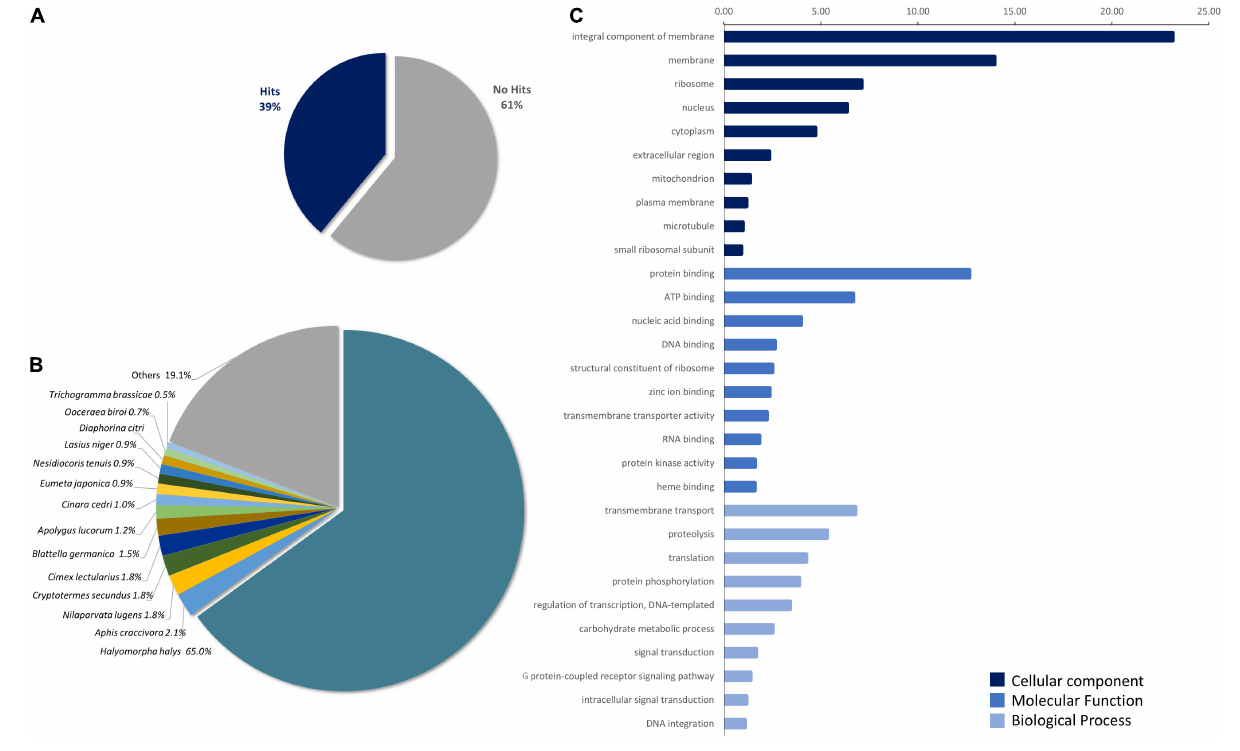
FIGURE 1 | Piezodorus guildinii transcriptome homology analysis. (A) Percentage of hits identified by BLASTx in P. guildinii transcriptome against nr-NCBI, Swiss-Prot, and TrEMBLE databases (cutoff E-Value < 10e-5). (B) Species distribution of transcripts with known function, hits from nr-NCBI database. (C) Gene Ontology (GO) terms in P. guildini transcriptome. Percentage distribution of 10 principal GO terms classified in Molecular Function (MF), Biological Process (BP), and Cellular Component (CC) assigned to P. guildinii contigs. Analysis was performed using hits from BLASTx and InterProScan using OmicsBox